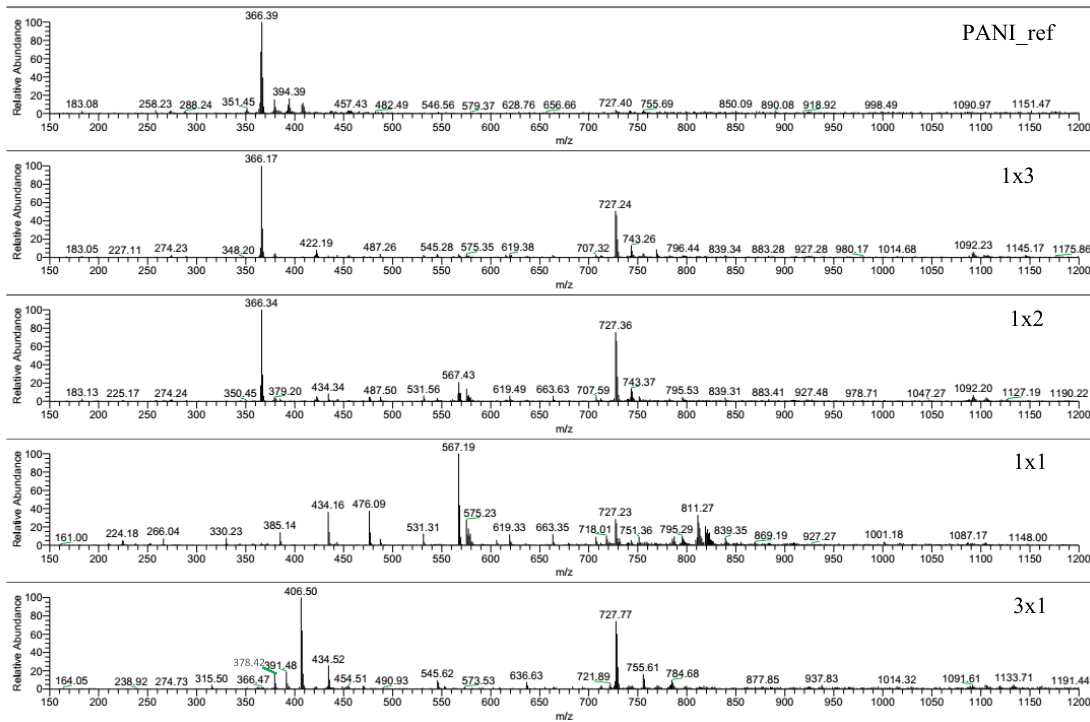
Figure 6. MS spectra of DMF-soluble fractions of PANI_ref, 1 × 3, 1 × 2, 1 × 1, and 3 × 1 samples.